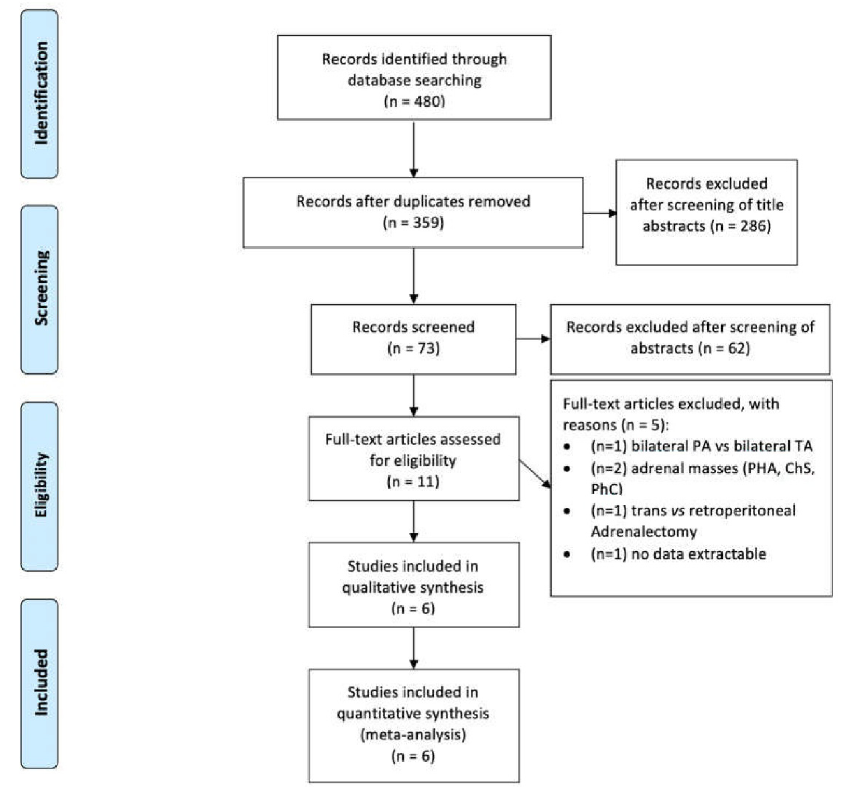
Figure 1. PRISMA flow chart.